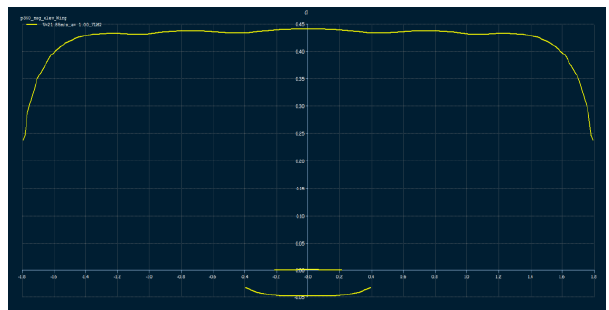
Figure 9. Distribution of Local Lift Coefficient with XFLR5 (Drela & Youngren, 2003)